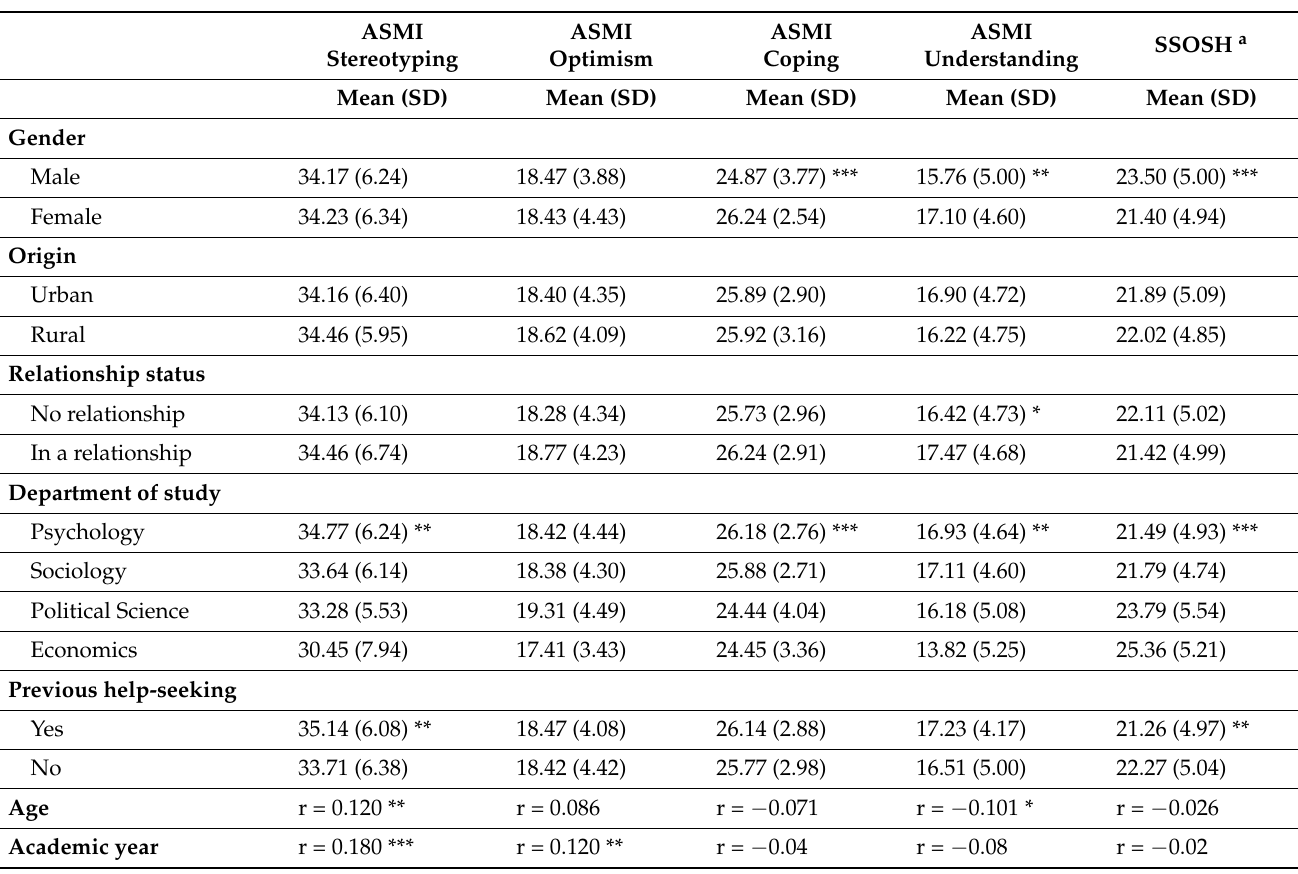
Abbreviations: ASMI: Attitudes towards Severe Mental Illness; SSOSH; Self-Stigma of Seeking Help Scale; SD: Standard Deviation. a Statistical significant differences at * p < 0.05, ** p < 0.01, *** p < 0.001, based on t -test, ANOVA or Pearson r correlation